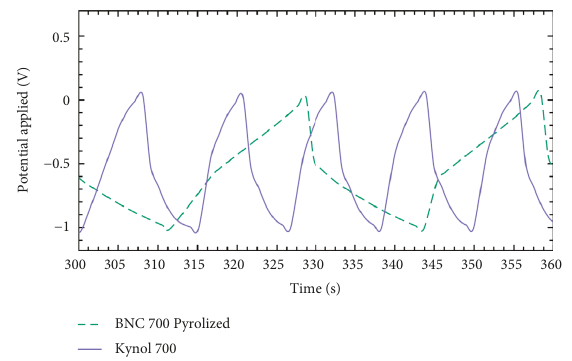
Figure 10: Galvanostatic charge-discharge over time.